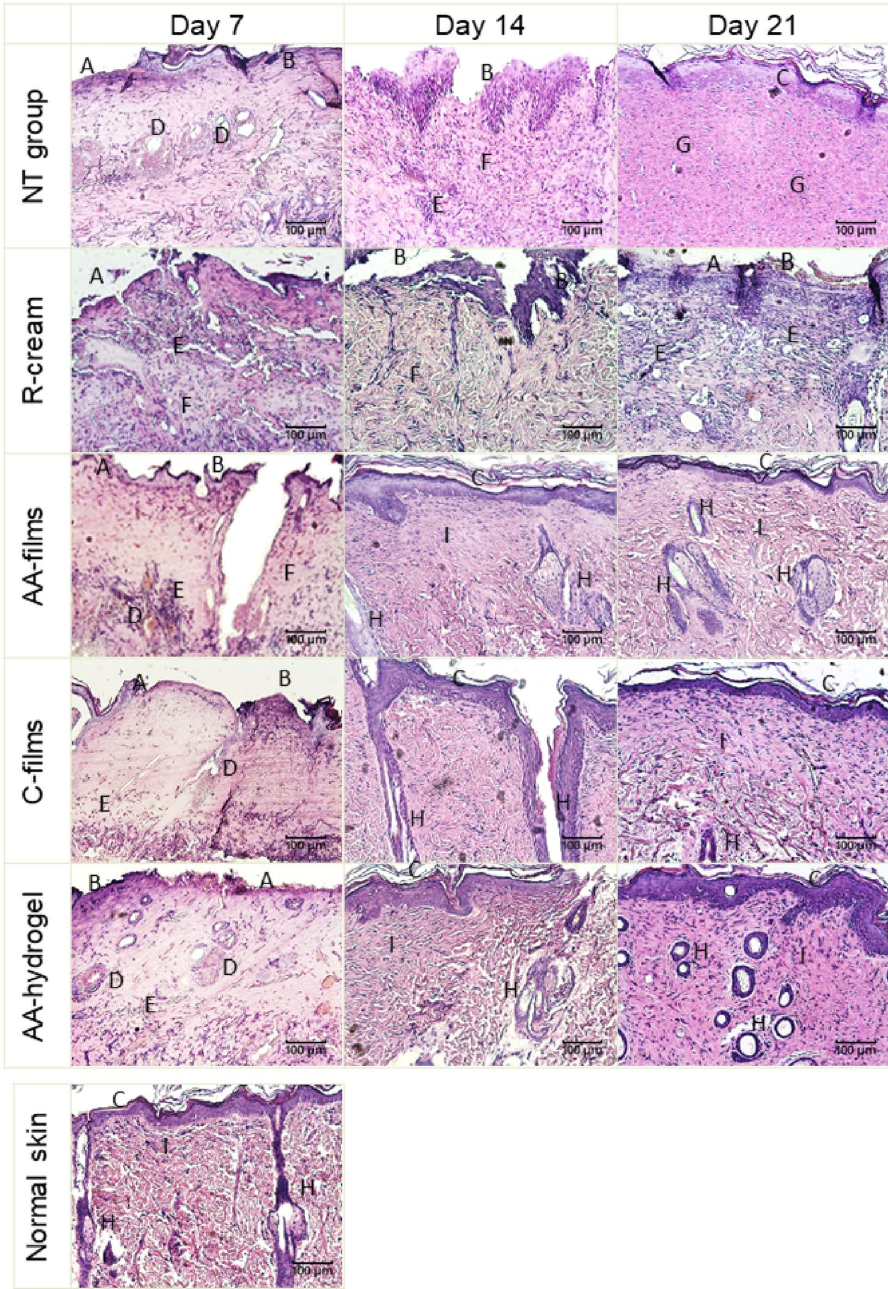
Figure 5. Representative photomicrographs of burn wounds for the NT group and after treatment with R-cream, AA-films, C-films or AA-hydrogel at days 7, 14, and 28 post wounding. H&E (× 100, scale bars: 100 μm). ( A ) Absent epidermis, ( B ) epidermis in regeneration, ( C ) continuous epidermis, ( D ) hemorrhagic appendages, ( E ) inflammatory cells, ( F ) dermal disorganization, ( G ) fibrous dermis, ( H ) appendages (hair follicles or glands), ( I ) differentiated papillary and reticular